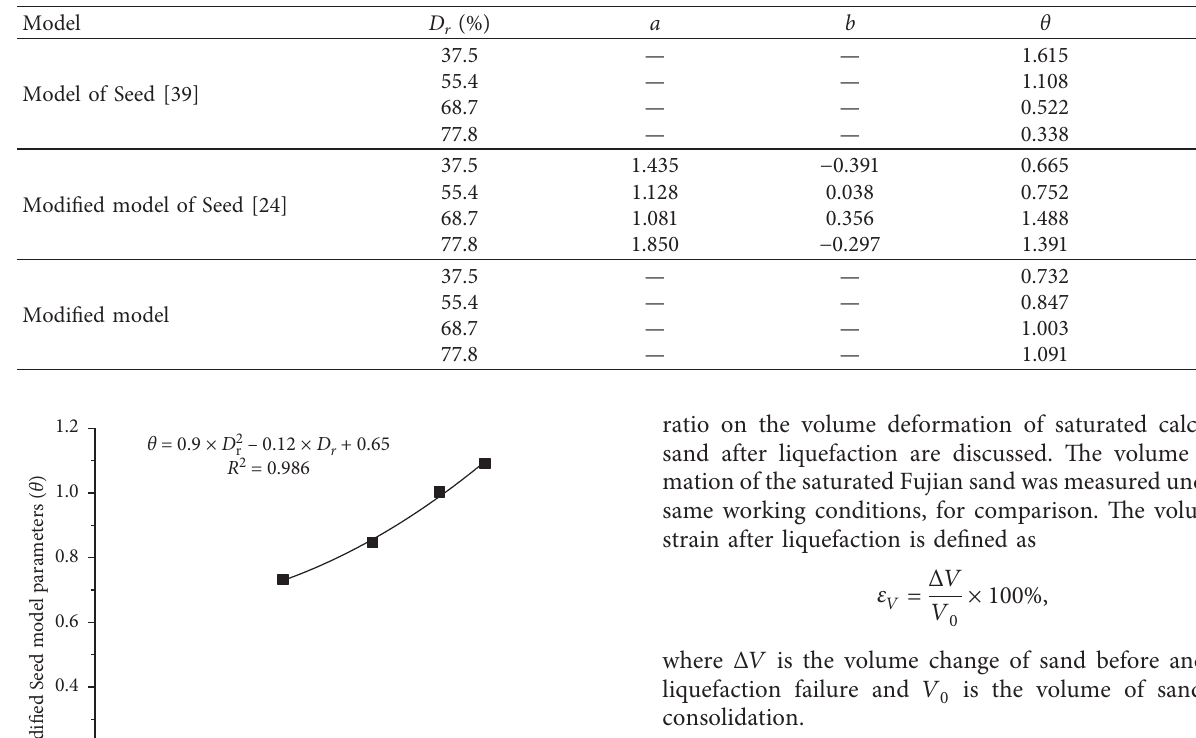
Table 3: Fitting coefficients of the model.